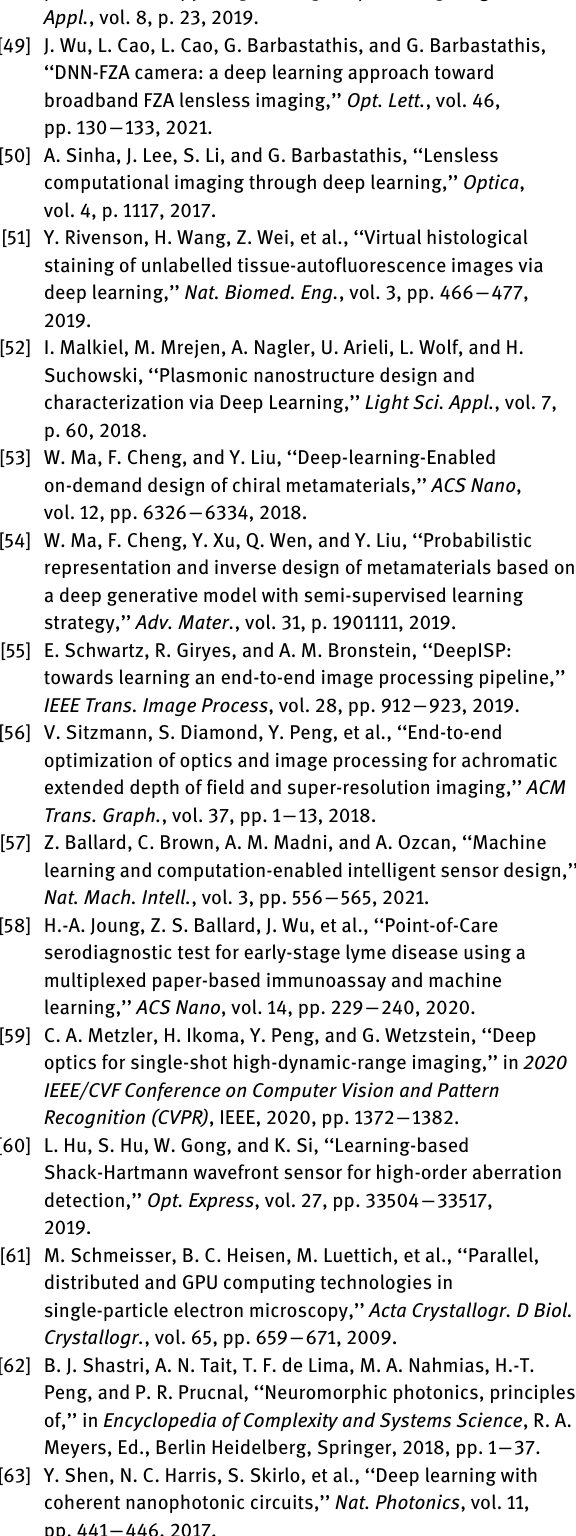
922 | D. Mengu et al.: All-optical permutation operation using diffractive